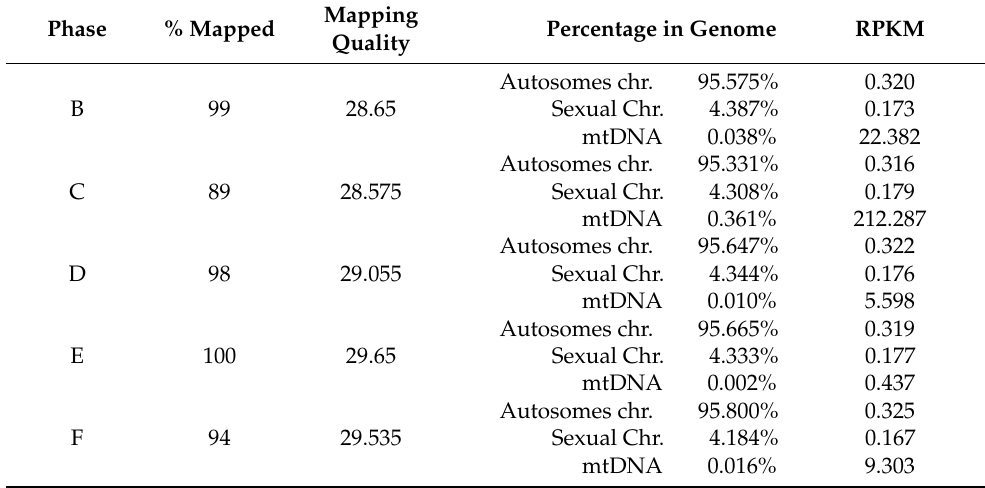
Table 4. NGS analyses of the samples comparing autosomes versus mitochondrial